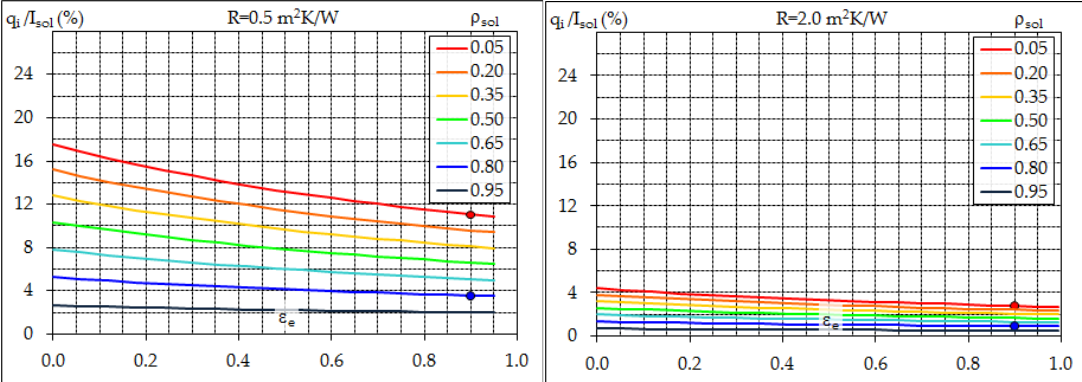
Figure 5. Ratio of peak transmitted heat flow rate and solar irradiance for T i = 27 ◦ C ∼ = 300 K, R si = 0.17 m 2 K/W, h ce = 12 W/(m 2 K) and (from left to right) uninsulated (R ≈ 0.5 m 2 K/W) and well insulated (R ≈ 2.0 m 2 K/W) roofs, both with negligible thermal